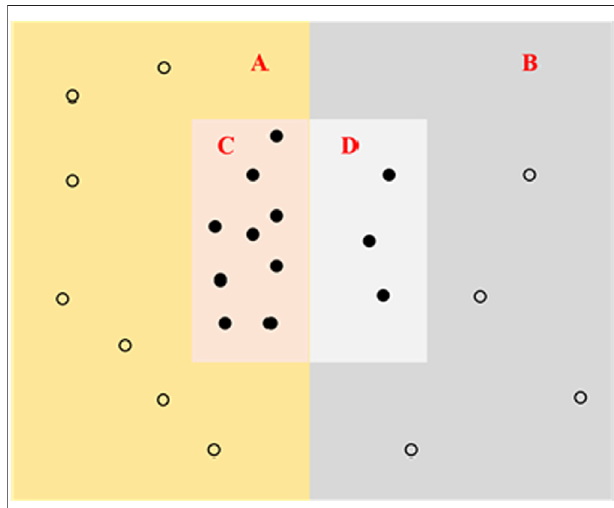
FIGURE 5 | Schematic diagram of precision and recall rate.